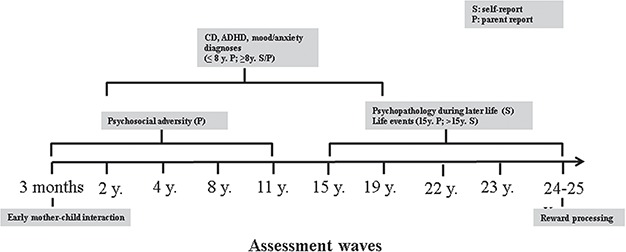
Assessment waves.